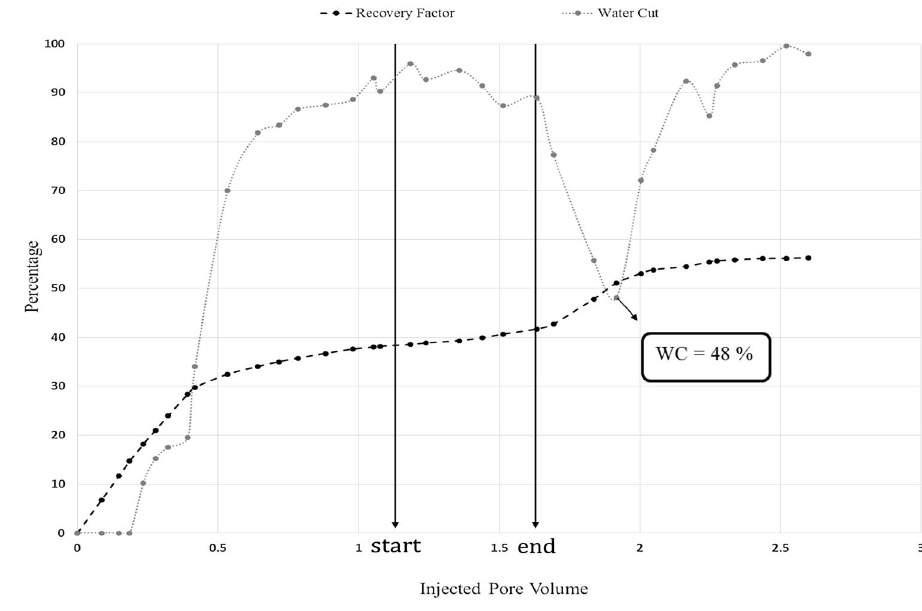
Fig. 7 Cumulative oil recovery and water cut during SW injec- tion and subsequent injection of emulsion 70/30 (test